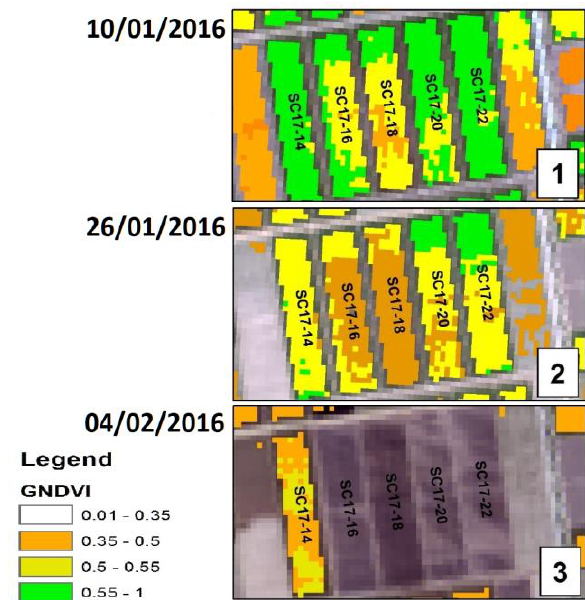
Figure 4. Farms classifications on different dates of 2016-2017 harvest